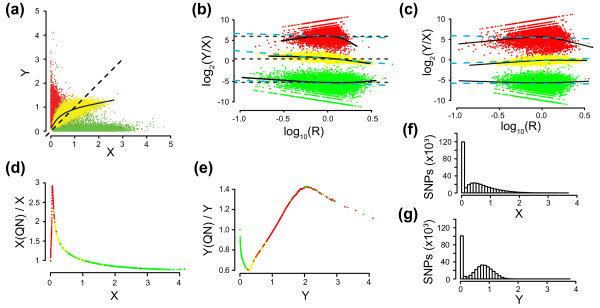
Intensity transformations of X and Y by quantile normalization. HapMap sample NA06985 hybridized on an Infinium 370 k BeadChip is shown. SNPs have been colored based on individual genotype calls: AA (green), AB (yellow), and BB (red). SNPs without genotype call are excluded. (a) Scatter plot of BeadStudio allele intensities X and Y. A lowess regression line for heterozygous SNPs is superimposed (solid) together with the expected X = Y line (dashed) illustrating that the dye intensity bias affects heterozygous SNPs. (b) MR plot of BeadStudio allele intensities for chromosome 8 with superimposed lowess regression lines (solid) for each genotype population and locally fitted linear regression lines (dashed blue). The mean M value for each genotype population is indicated by horizontally dashed black lines. (c) MR plot of quantile normalized allele intensities for chromosome 8 with superimposed lowess regression lines (solid black) and locally fitted linear regression lines (dashed blue) for each genotype population, separately. (d) Scatter plot of the intensity transformation XQN/X vs X from quantile normalization. SNPs are colored by genotype. SNPs with low X intensity values (predominantly genotyped as BB) are increased significantly in intensity by QN. (e) Scatter plot of the intensity transformation YQN/Y vs Y from quantile normalization. SNPs are colored by genotype. (f) Histogram of BeadStudio X intensities. (g) Histogram of BeadStudioY intensities.